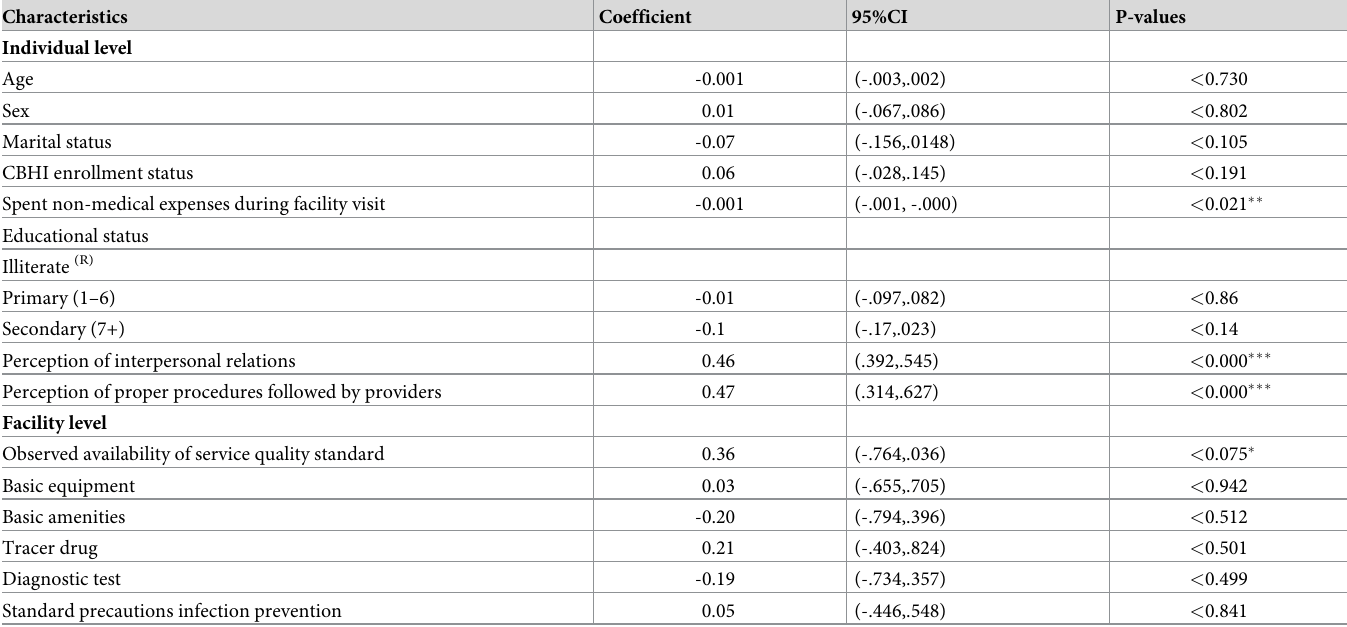
Table 4. Predictors of overall client satisfaction with quality of health service